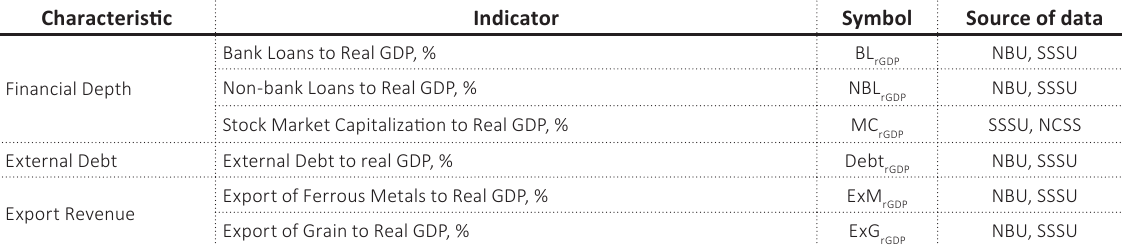
Characteristic Indicator Symbol Source of